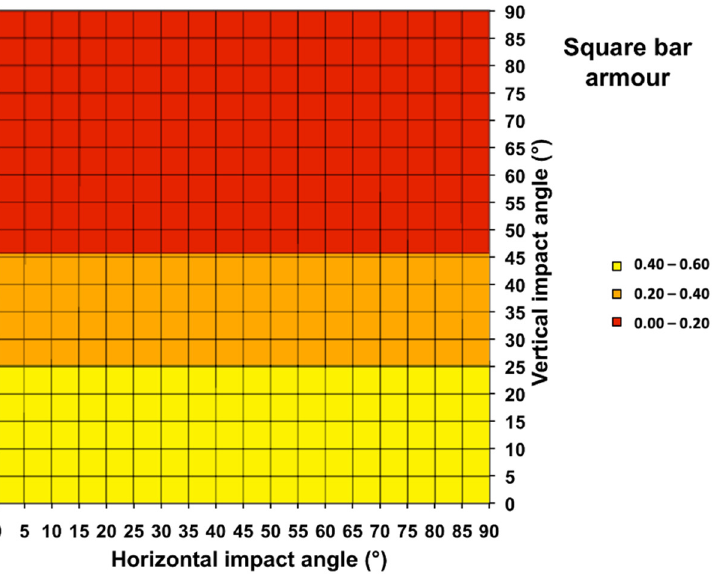
Figure 19. Efficiency of a steel square bar cage armour solution as a function of the horizontal and vertical impact angle.